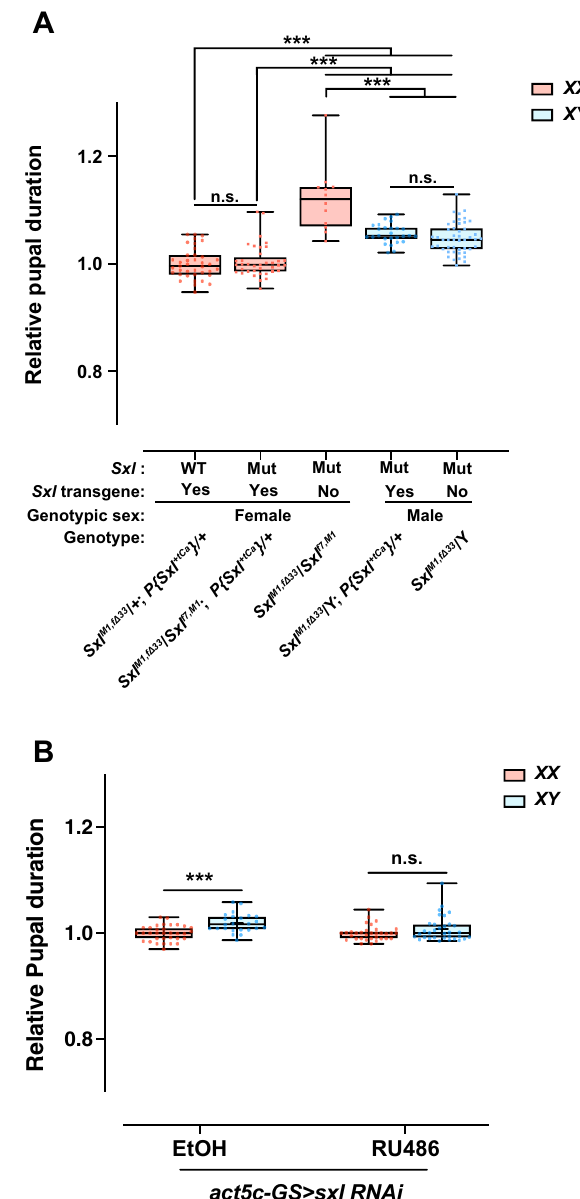
Figure 4. Alteration of Sxl expression affects the protogyny phenotype. ( A ). Effect of Sxl mutation on the protogyny phenotype in flies harboring or those not harboring the Sxl transgene. ( B ) Effect of act5c-GS > Sxl RNAi on the protogyny phenotype in flies grown on media with or without RU486, a glucocorticoid receptor antagonist. Whiskers indicate minimum and maximum values (*** p < 0.001; n.s., no significant difference by Student’s unpaired t